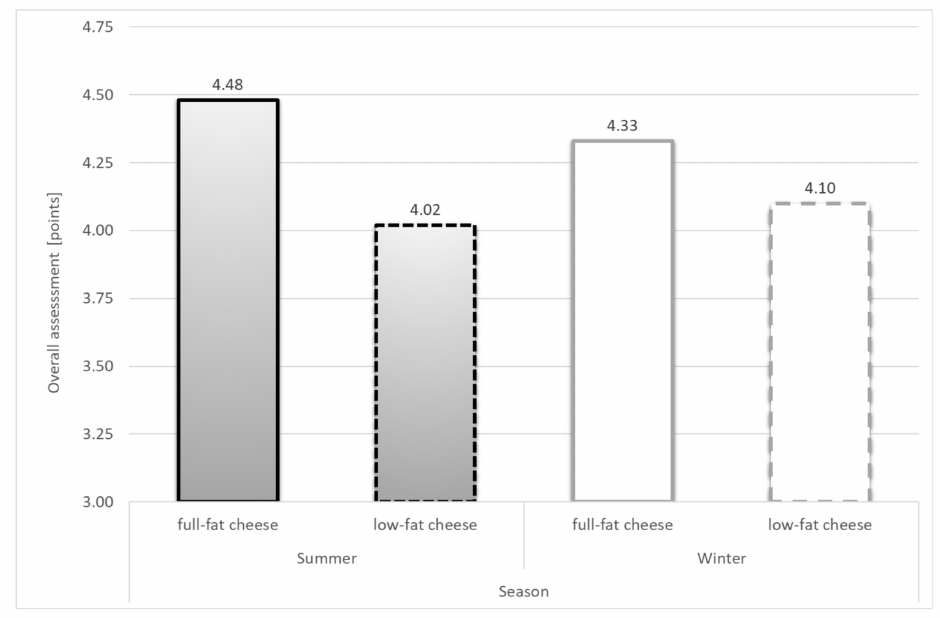
Figure 2. Overall assessment of the cheeses